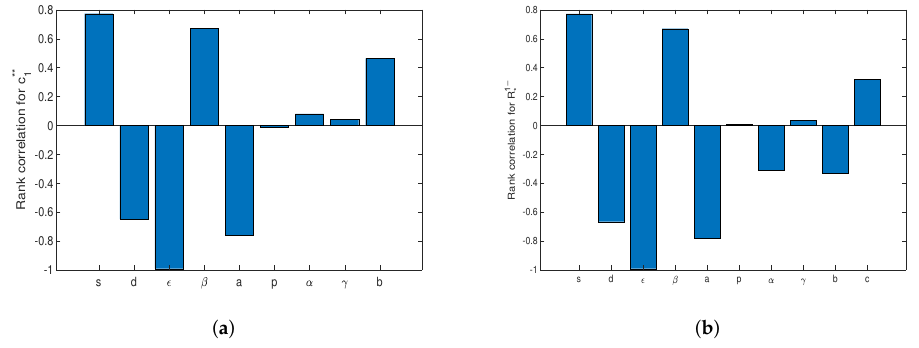
Figure 5. Partial rank correlation coefficients illustrating the dependence of c ∗∗ the system (1) on each parameter. The parameter values are listed in Table 3.